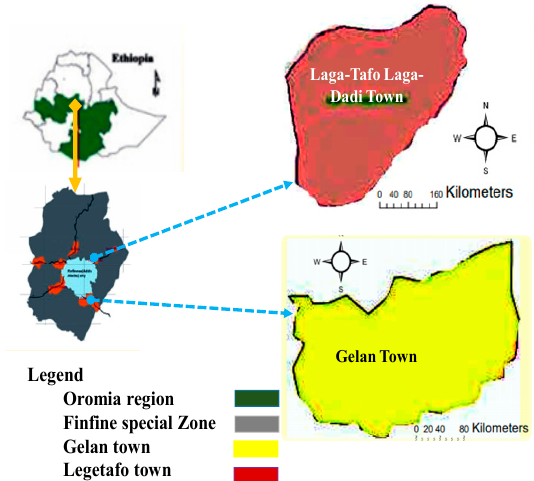
Figure 1. Map showing the locations of the study areas.